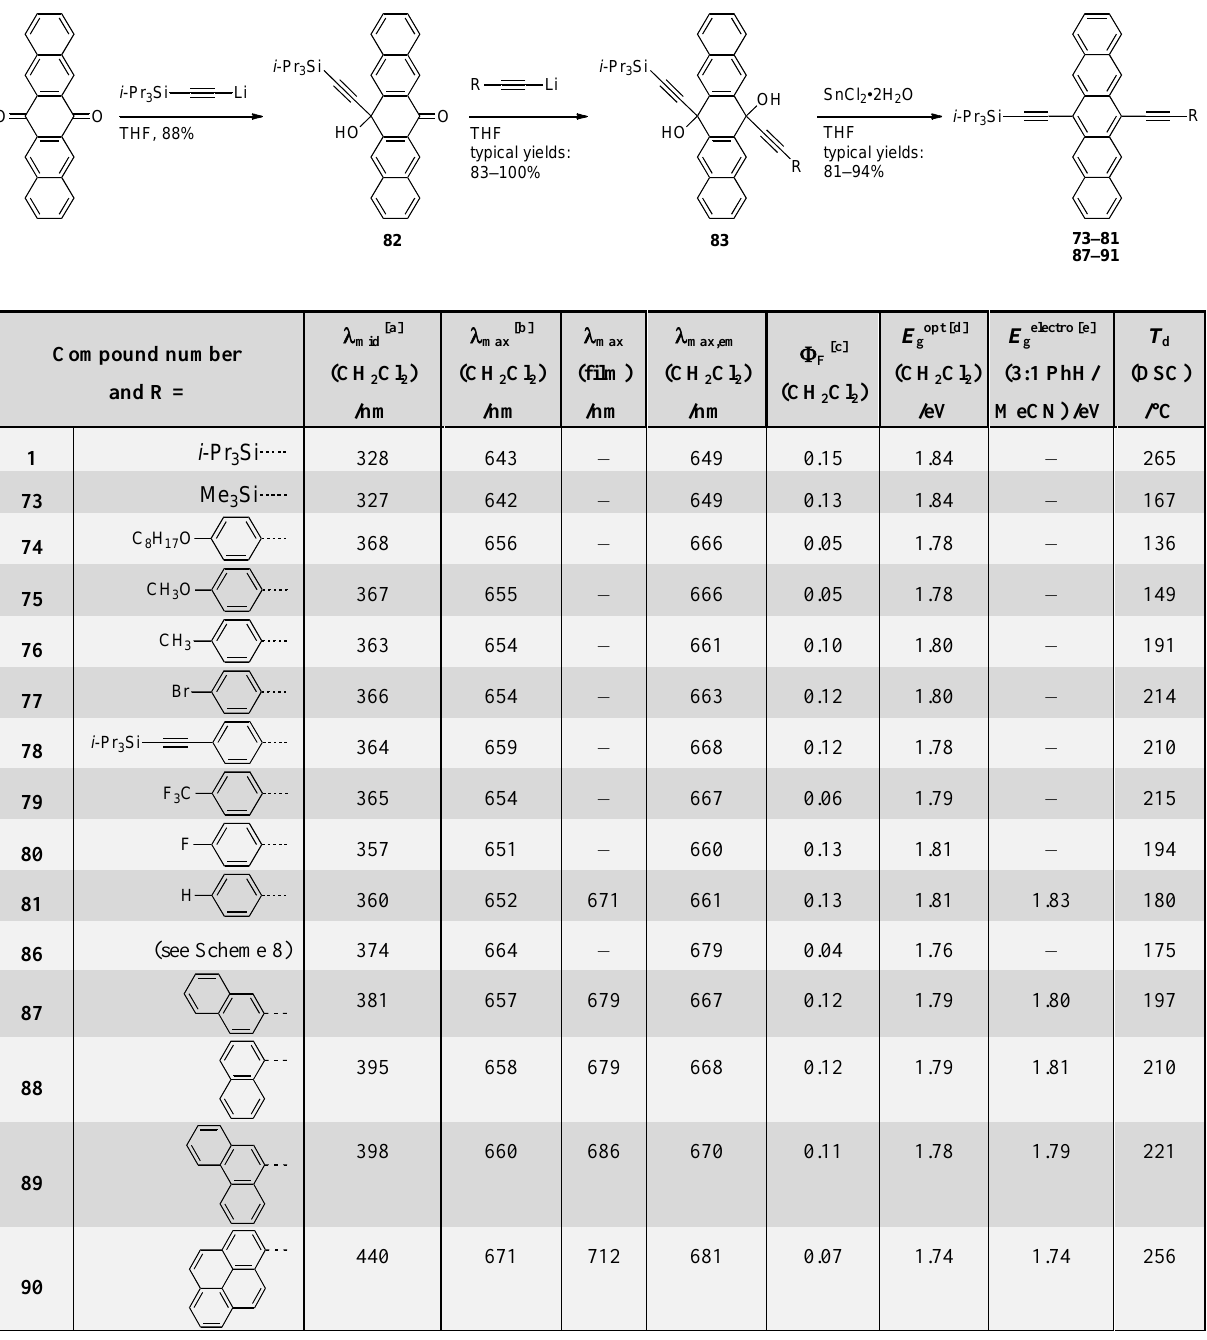
Table 2. Pentacenes dyads and reported optical